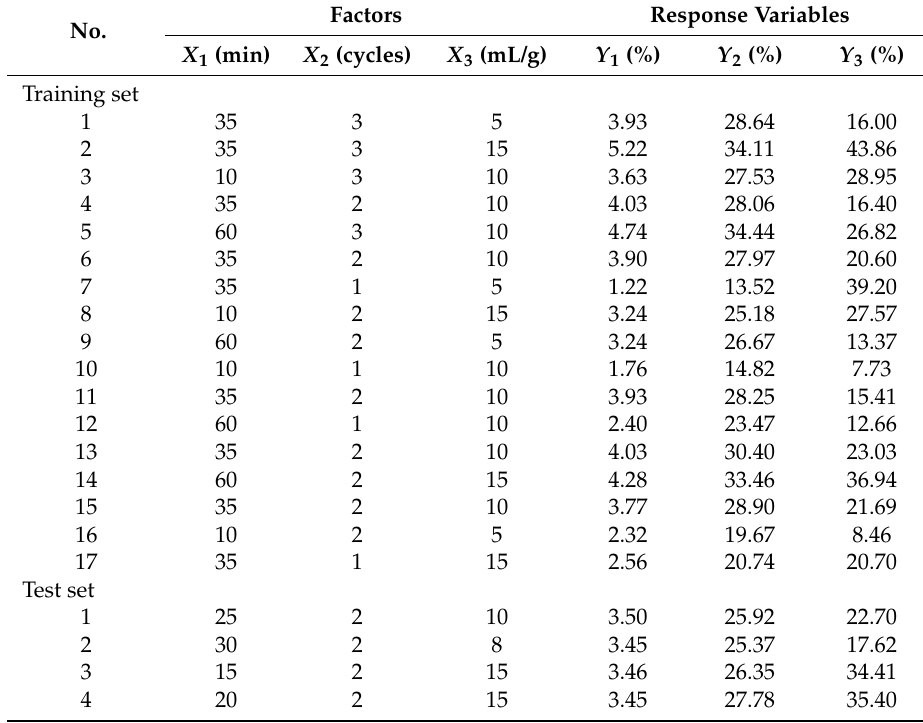
Table 1. Results of training and test